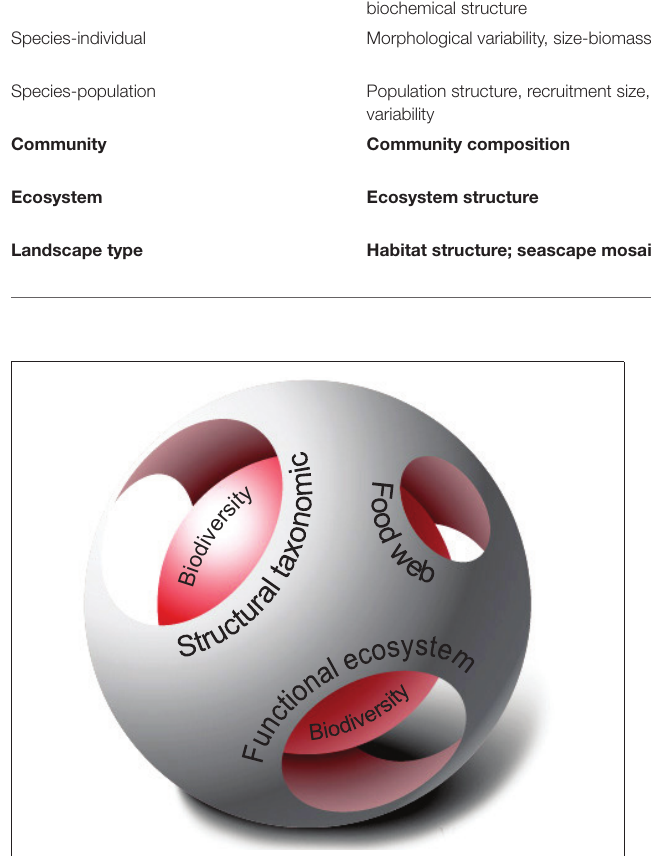
FIGURE 1 | Schematic illustration of a pragmatic simplification of marine biodiversity, where a restricted extent of information is selected depending on the relevant viewpoints and questions asked. Base image courtesy of Iaroslav Lazunov, http://vectorboom.com/